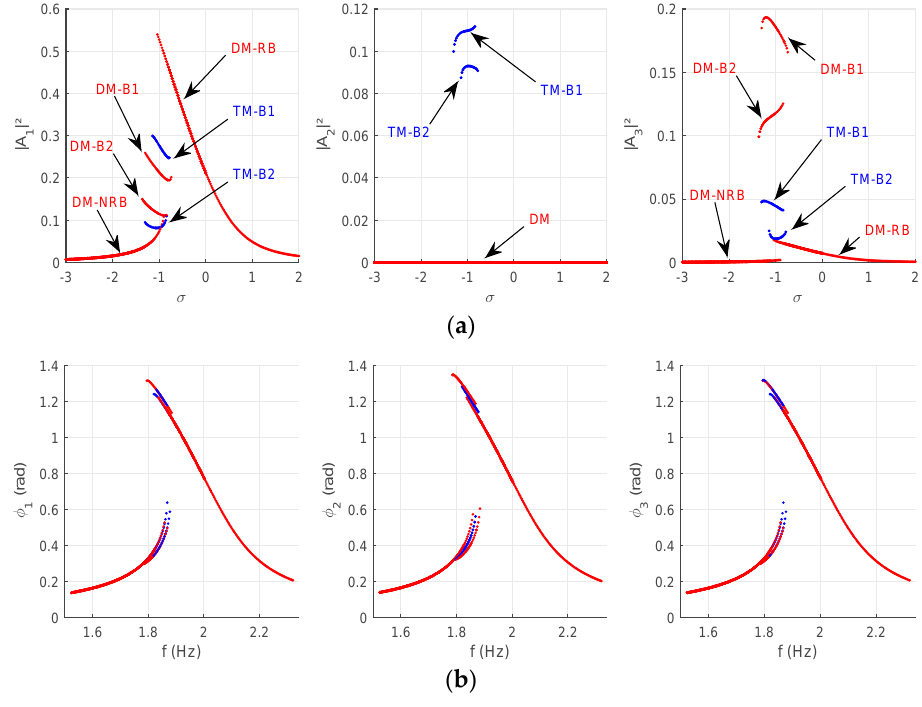
Figure 11. Deterministic ( a ) modal responses amplitudes | A 1 | 2 , | A 2 | 2 and | A 3 | 2 and ( b ) physical responses amplitudes φ 1 , φ 2 and φ 3 , of the